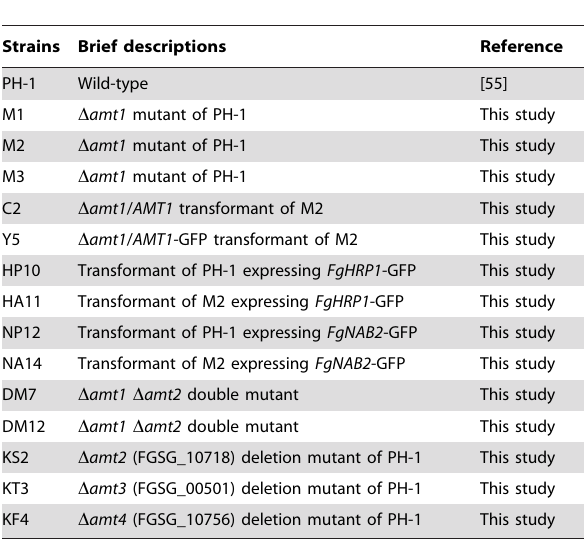
Table 1. The wild-type and mutant strains of Fusarium graminearum used in this study.